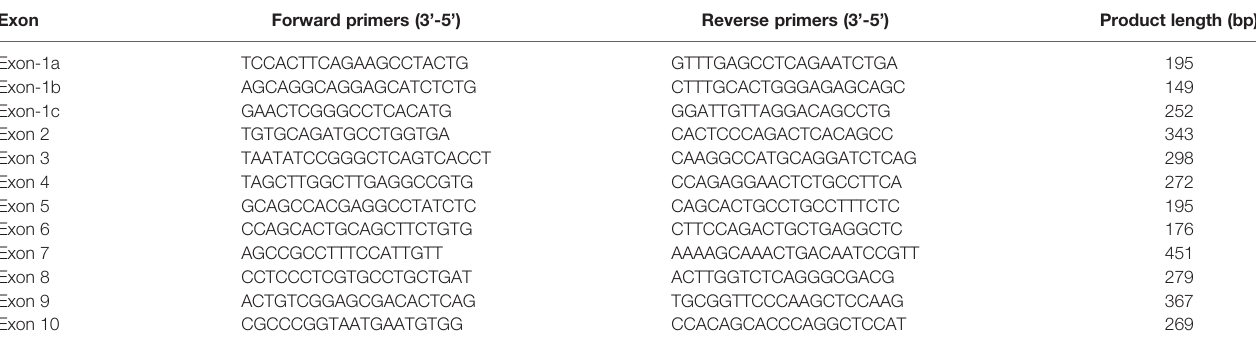
TABLE 1 | Ampli fi cation and sequencing primers for the GCK